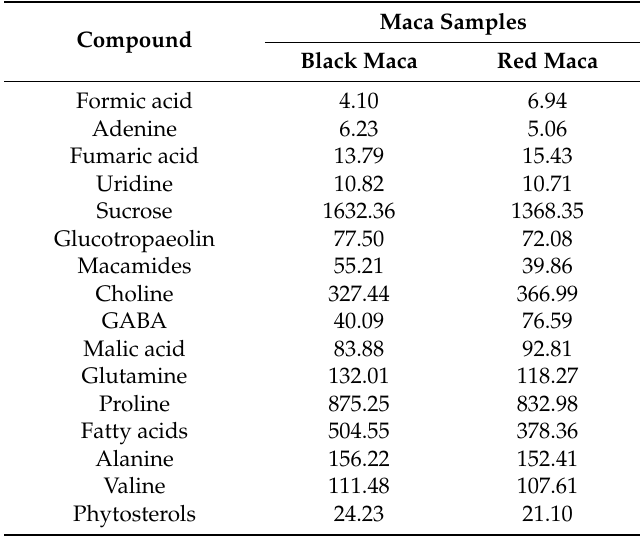
Table 1. Composition of spray-dried extracts of red and black maca screened using nuclear magnetic